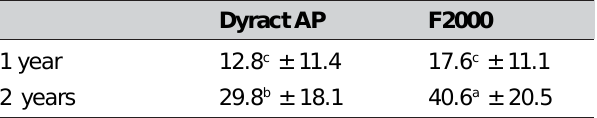
* Different superscript letters indicate statistically significant differences between means